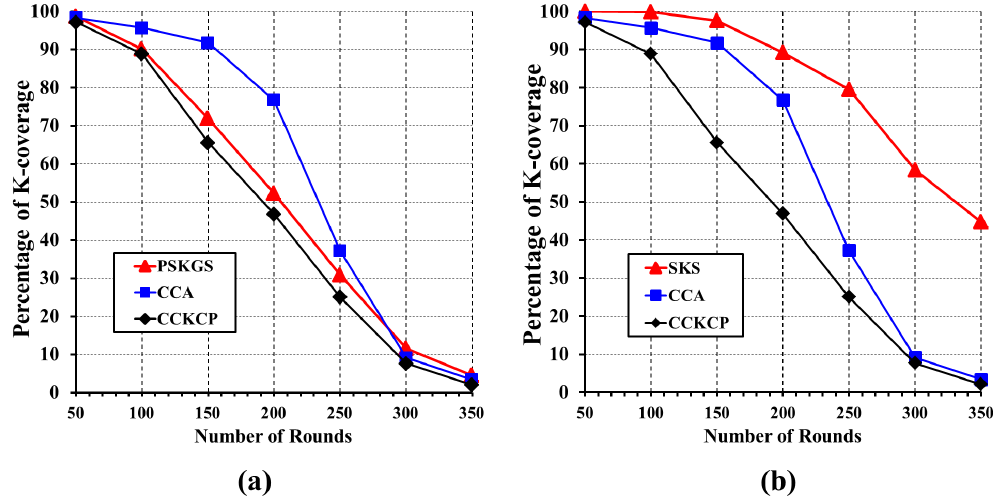
Figure 18. The network lifetime comparison of ( a ) PSKGS, CCA [31] and CCKCP [32] and ( b ) SKS, CCA [31] and CCKCP